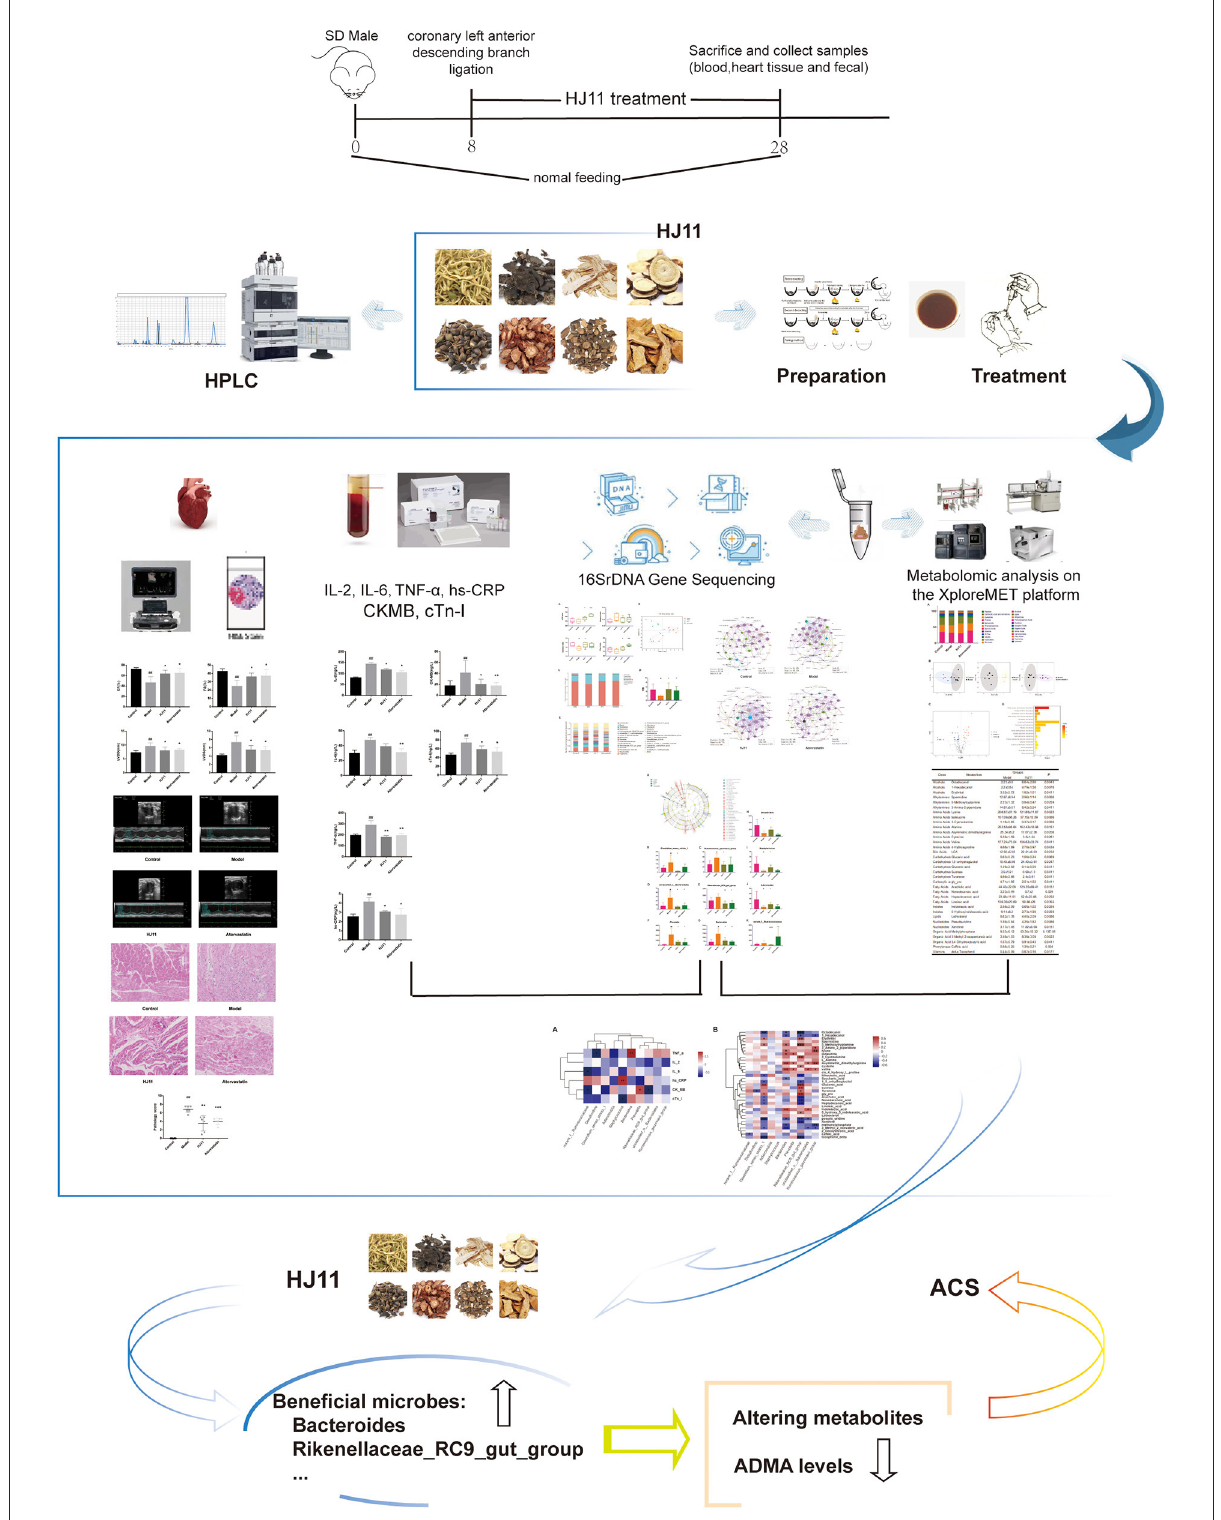
FIGURE1 Workflow for predicting the therapeutic mechanism of HJ11 in